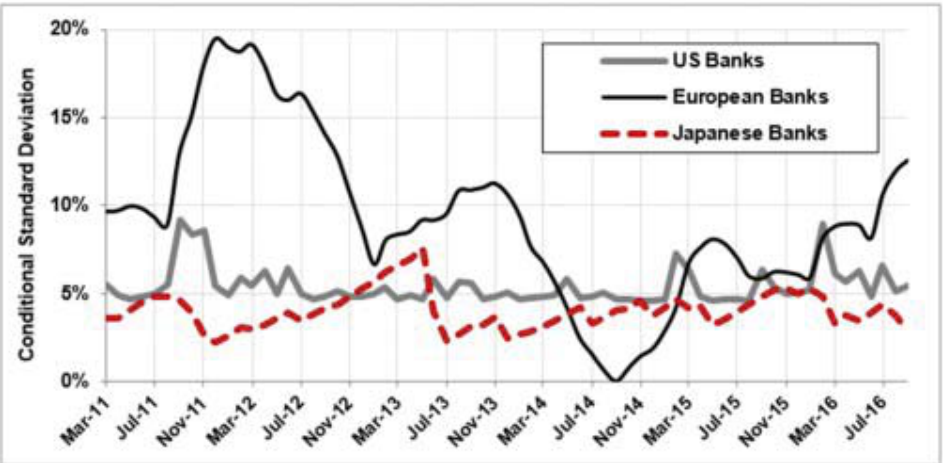
Fig. 4. Conditional Volatility of Monthly Stock Returns for U.S., European and Japan Bank Stocks, March 2011-September